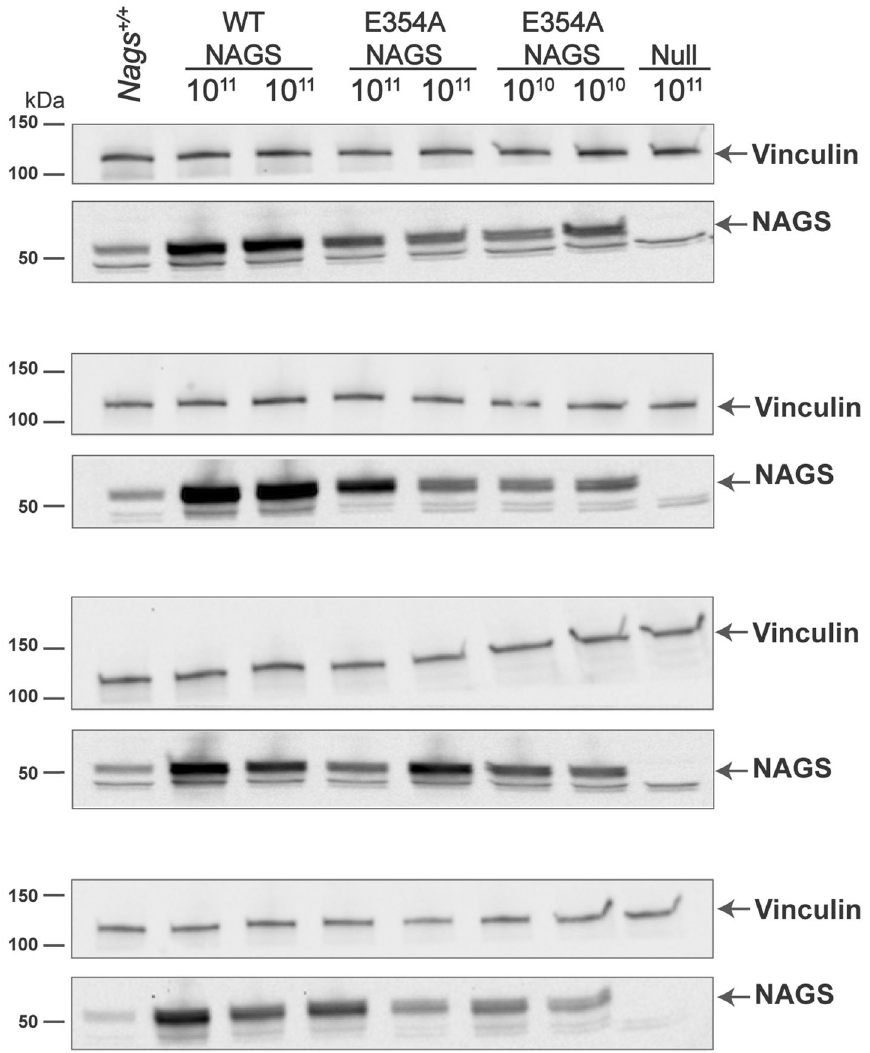
Figure 7. NAGS protein in the livers of Nags −/− mice injected with 10 11 viral particles of the AAV2/8NAGS. mNAGS vector (WT NAGS lanes), with either 10 11 or 10 10 viral particles of the AAV2/8NAGS.E354A-mNAGS vector (E354A NAGS lanes), or with 10 11 viral particles of the AAV2/8TBGnull vector (Null). Vinculin was used as a loading control. Full-length immunoblots are presented in Supplementary Fig.